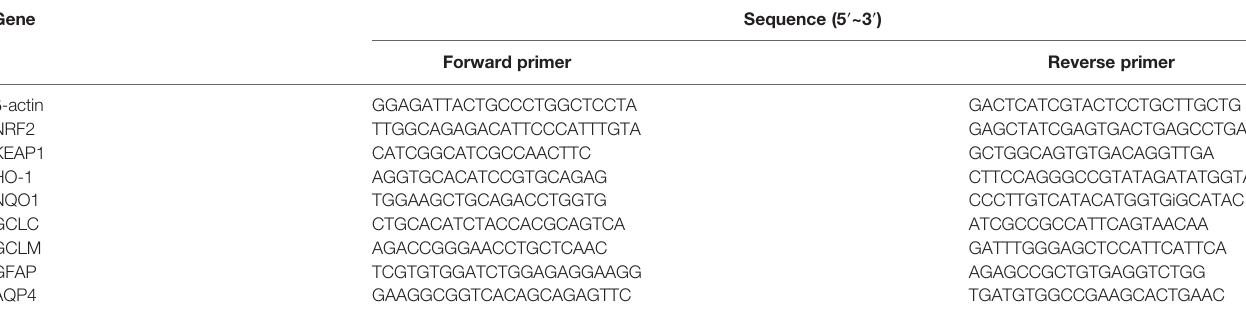
TABLE 1 | The primer sequence for